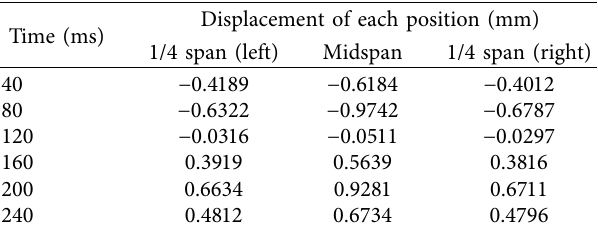
Table 5: Displacement of measuring points at each time.